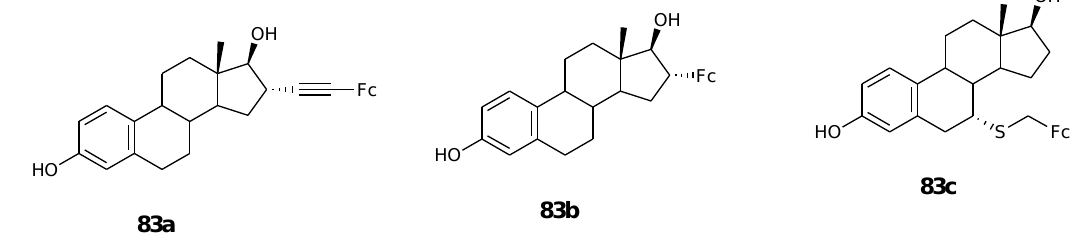
Figure 30. Hybrid compounds 83a – c .